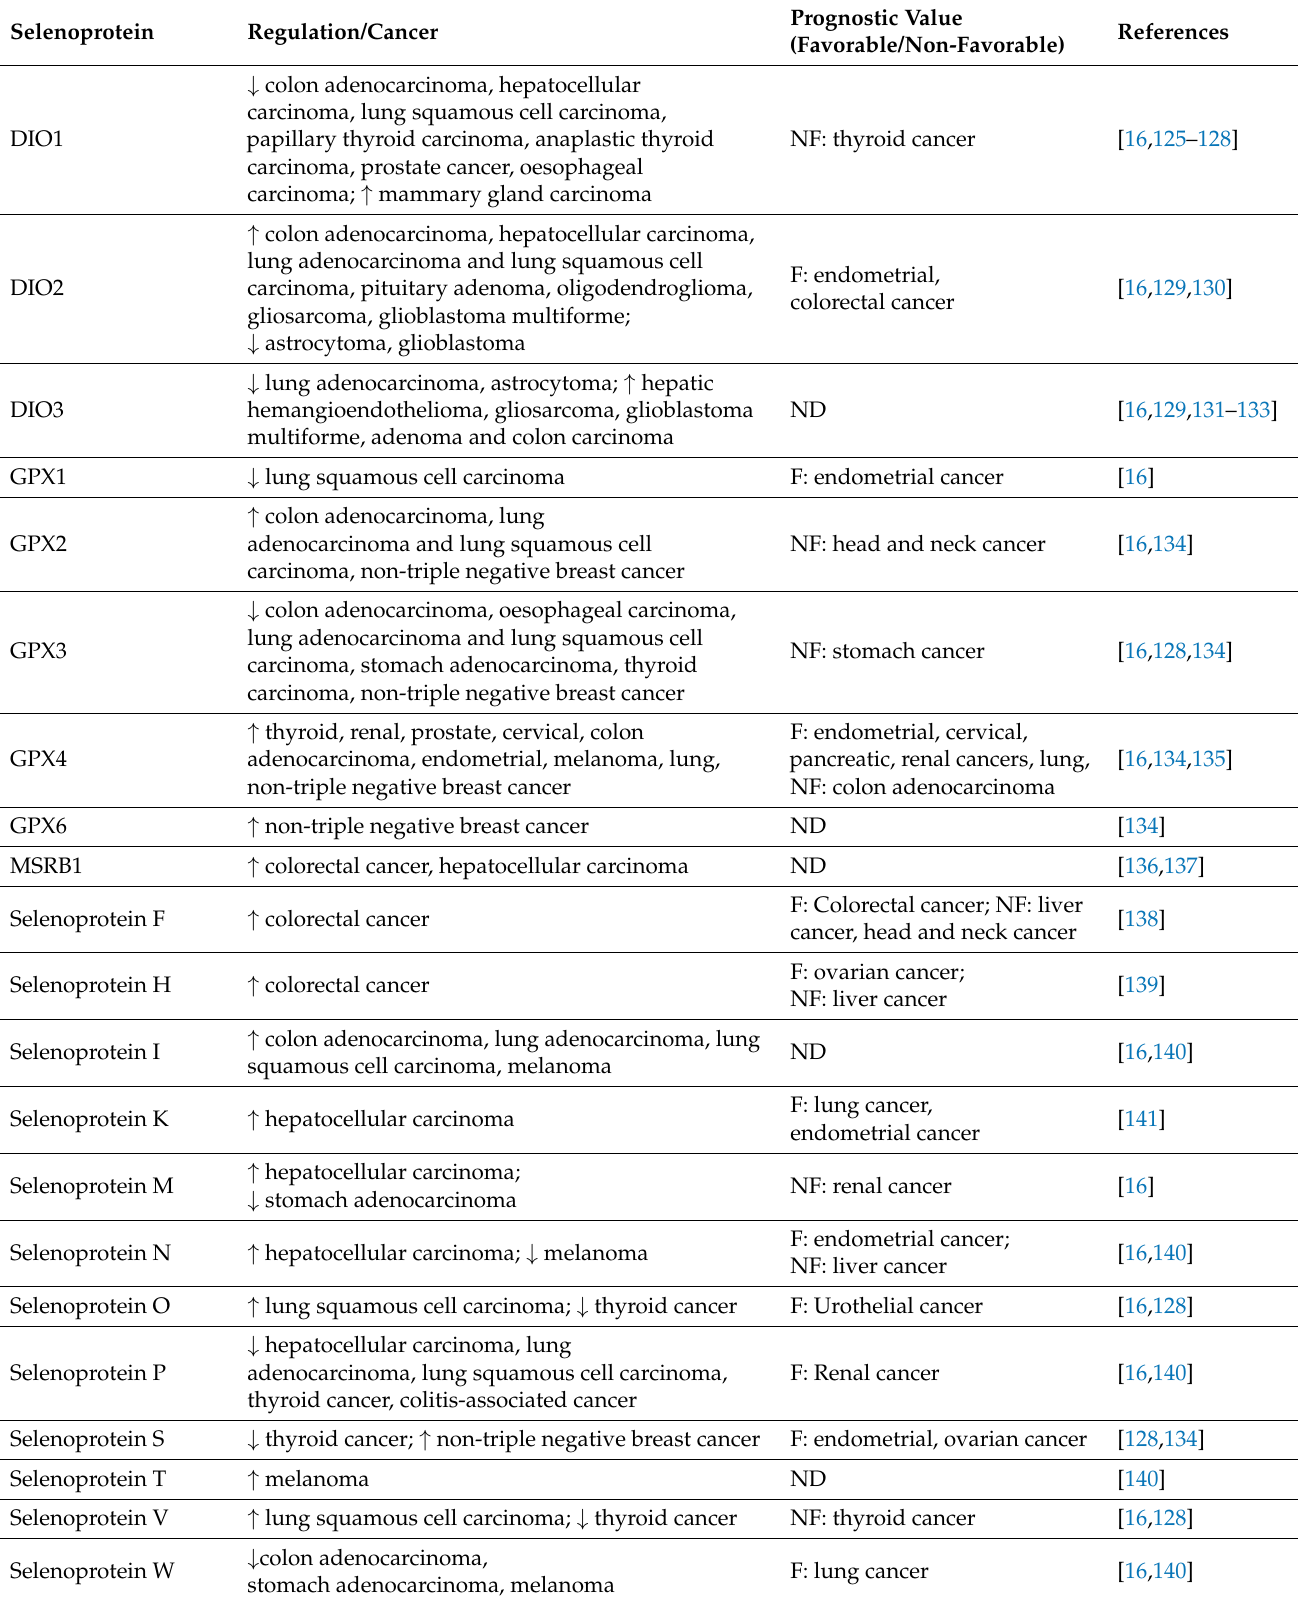
Table 1. Selenoproteins and their regulation ( ↑ upregulation, ↓ downregulation) and prognostic value in cancer